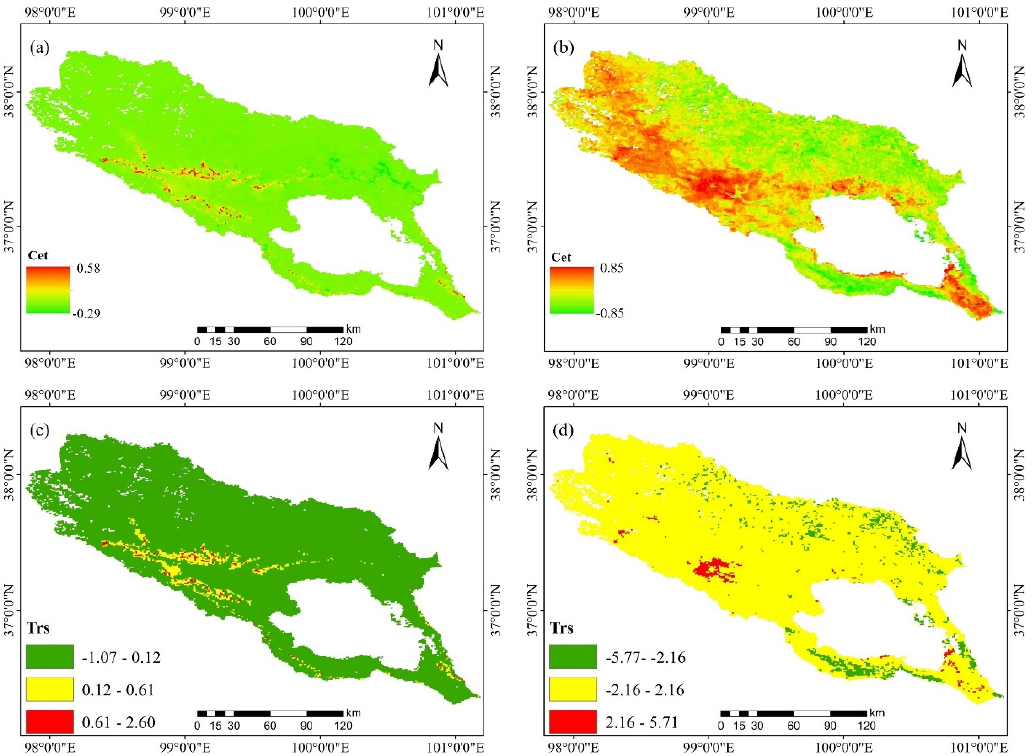
Figure 7. Spatial correlations of temperature ( a ), precipitation ( b ) with VWC and the t -test results in the Qinghai Lake Basin from 2000 to 2014. Figure ( c ) represents the t-test results of the correlation between temperature and VWC; figure ( d ) represents the t-test results of the correlation between precipitation and VWC. Cet and Trs represent correlation coefficient and the t -test results, respec- tively.